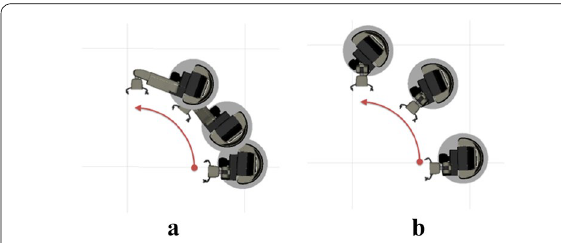
Fig. 18 Whole body planning with priority [3]. a Arm priority, b Base priority